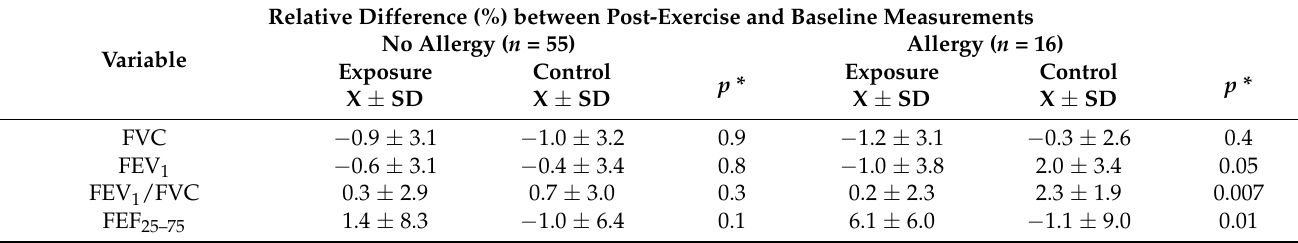
The correlation analysis showed that only in the allergy group, there were statistically significant negative correlations between post-exercise FEV 1 /FVC change and 3 h